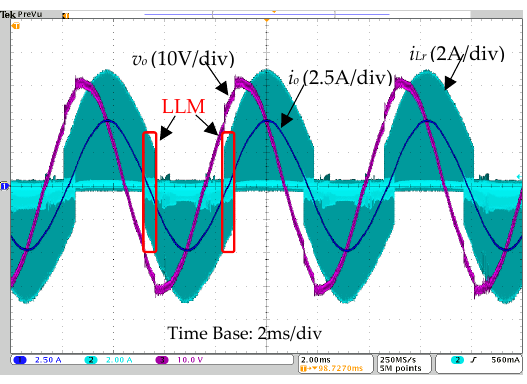
Figure 14. Experimental waveforms of ARSI without dead ‐ time compensation when the modulation index is 0.4 in an open ‐ loop configuration.